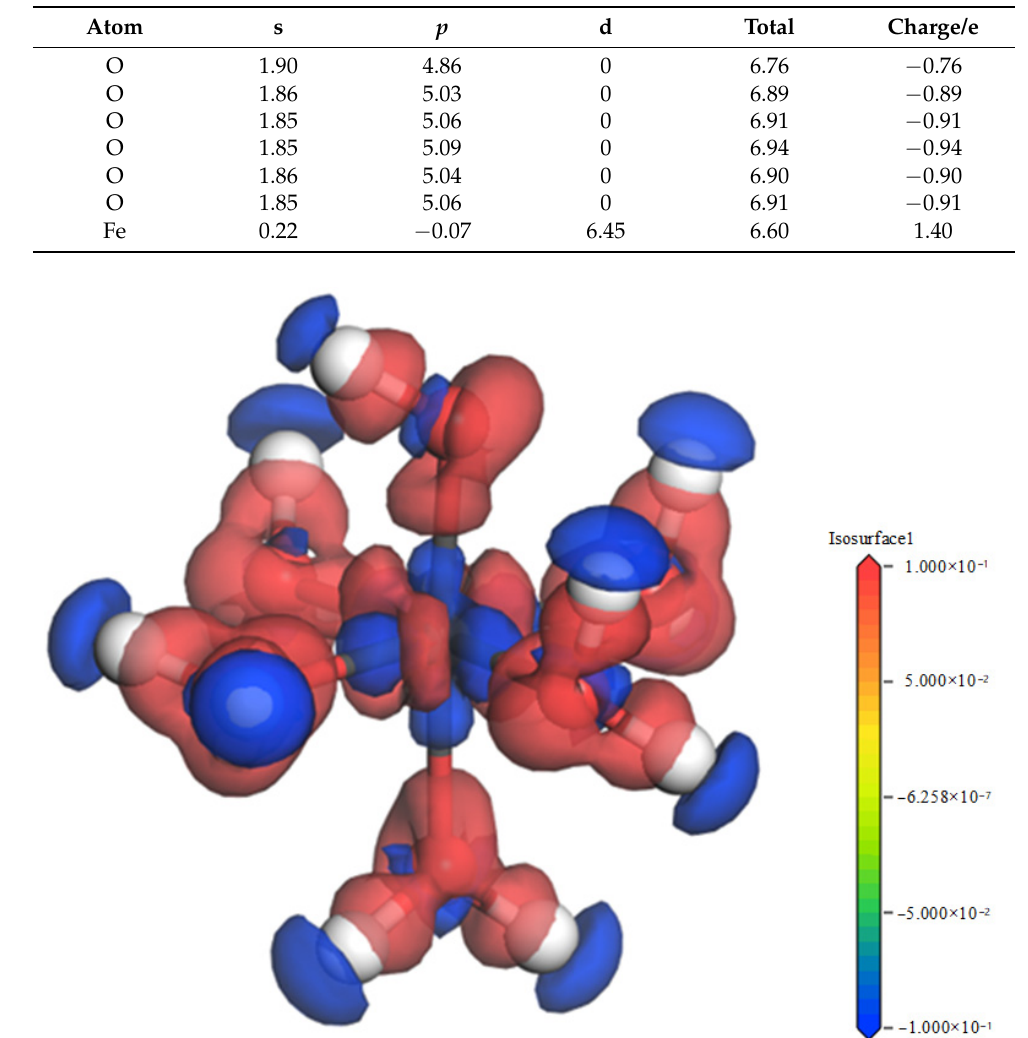
Table 2. Milliken charge population of Fe(OH)(H 2 O) 52+ .